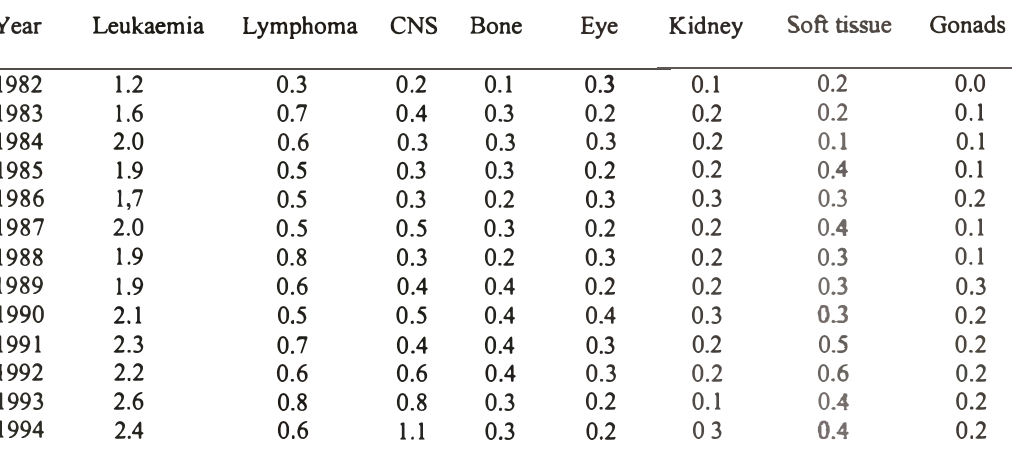
Table 8: Incidence rate (per 100,000 children per year) by selected disease categories: 1982-1994 Disease categories